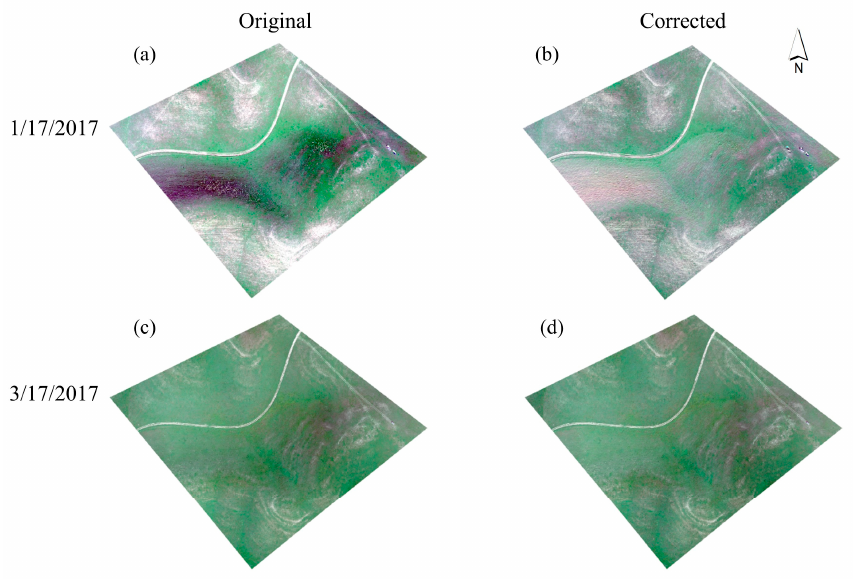
Figure 3. Original ( a , c ) and terrain corrected ( b , d ) example images, in true color composite, acquired from the sUAS on ( a , b ) 17 January 2017 and ( c , d ) 17 March 2017. The C model removed most of the topographic illumination effect ( b , d ) as presented in the original images ( a , c ). The shadow (pixels in very dark color) on the north-facing slopes is removed in the corrected images.